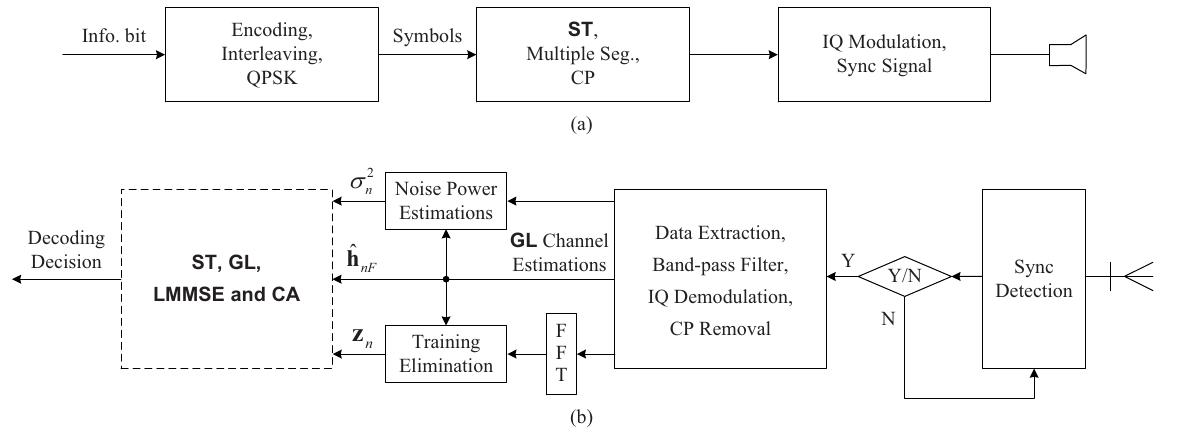
Figure 2. System structure. ( a ) Transmitter; ( b )